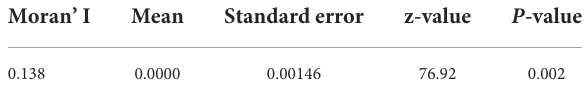
TABLE 5 The global Moran’ I of land patch level carbon